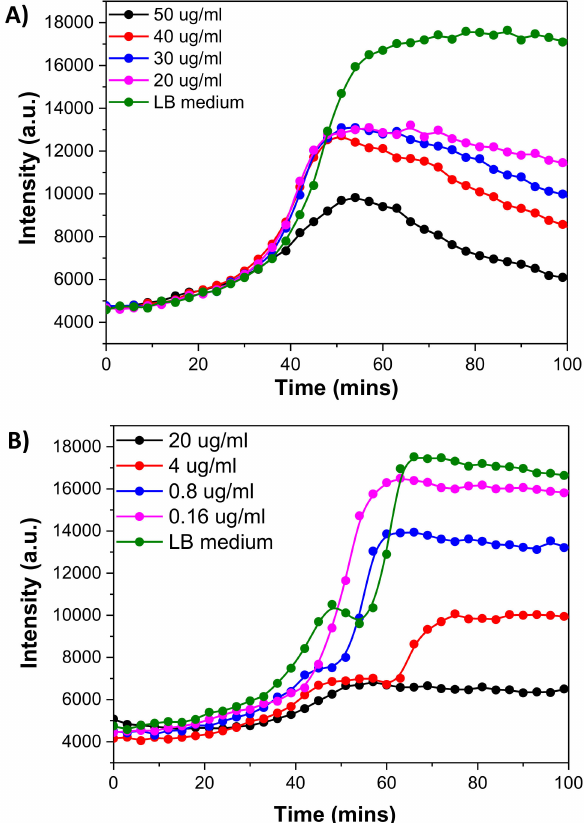
Figure 12. Inhibition of oxygen consumption monitored using micelle M2 by ampicillin ( A ) and antimycin A ( B ) as typical antibiotics. The initial concentration of E. coli is 2 × 10 6 cfu / mL. Experiments were carried out with mineral oil